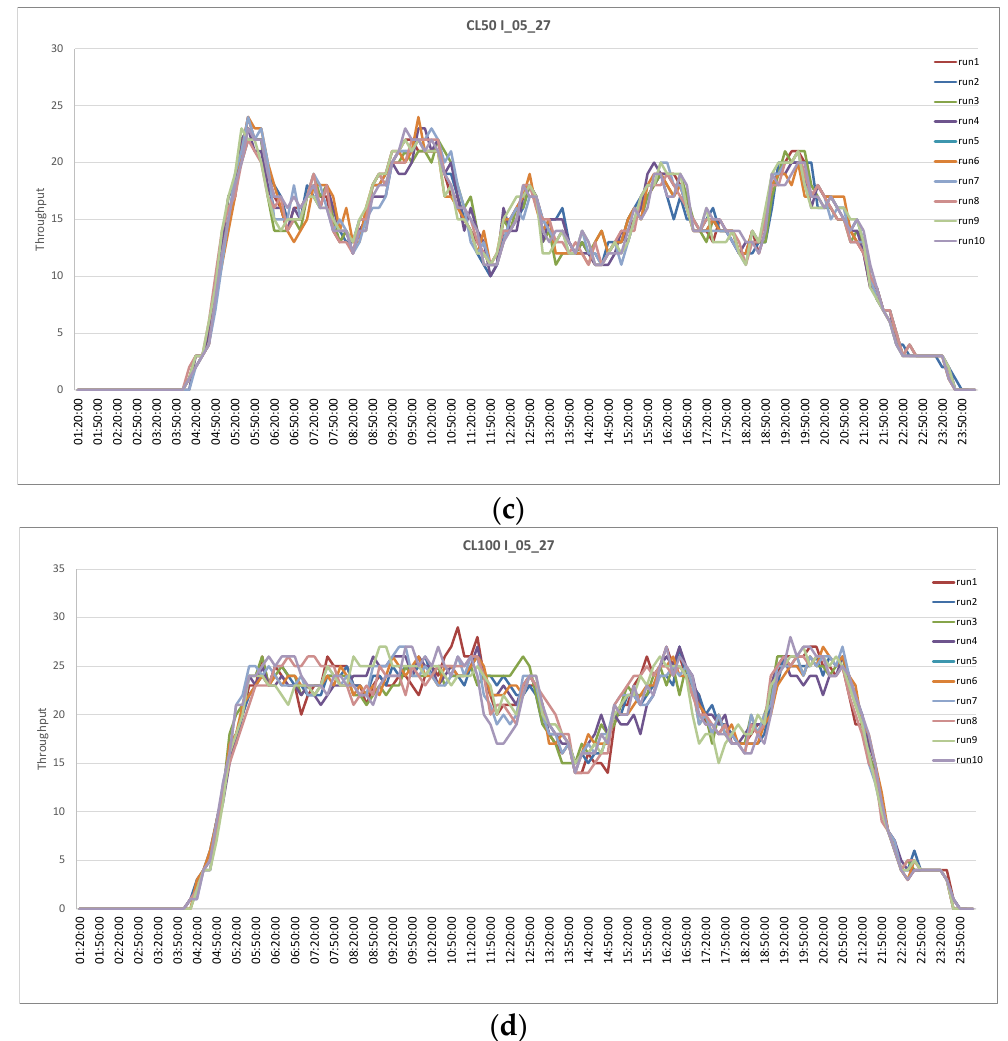
Figure 5. Throughput for I_05_27 ( a ) CL00; ( b ) CL10; ( c ) CL50; ( d ) CL100. Figure 6 represents the envelope of the Pareto frontier (green line) obtained for I_05_27 clones from CL00 to CL50: the FTS software has increased by 50% the current arrival/departure mix to obtain that of CL50. In the balanced mode (i.e., on the main diagonal), the overall number of movements is 22 (11 departures and 11 arrivals), and it is the maximum throughput value that ensures a not more than 10 min delay. Once identified the maximum balanced throughput, it is taken as a reference for identifying other points on the frontier, varying the number of movements, and having delay values under the established threshold. Therefore, points obtained for clones with more than 50% traffic increase are not represented because they refer to average delay values over 10 min.